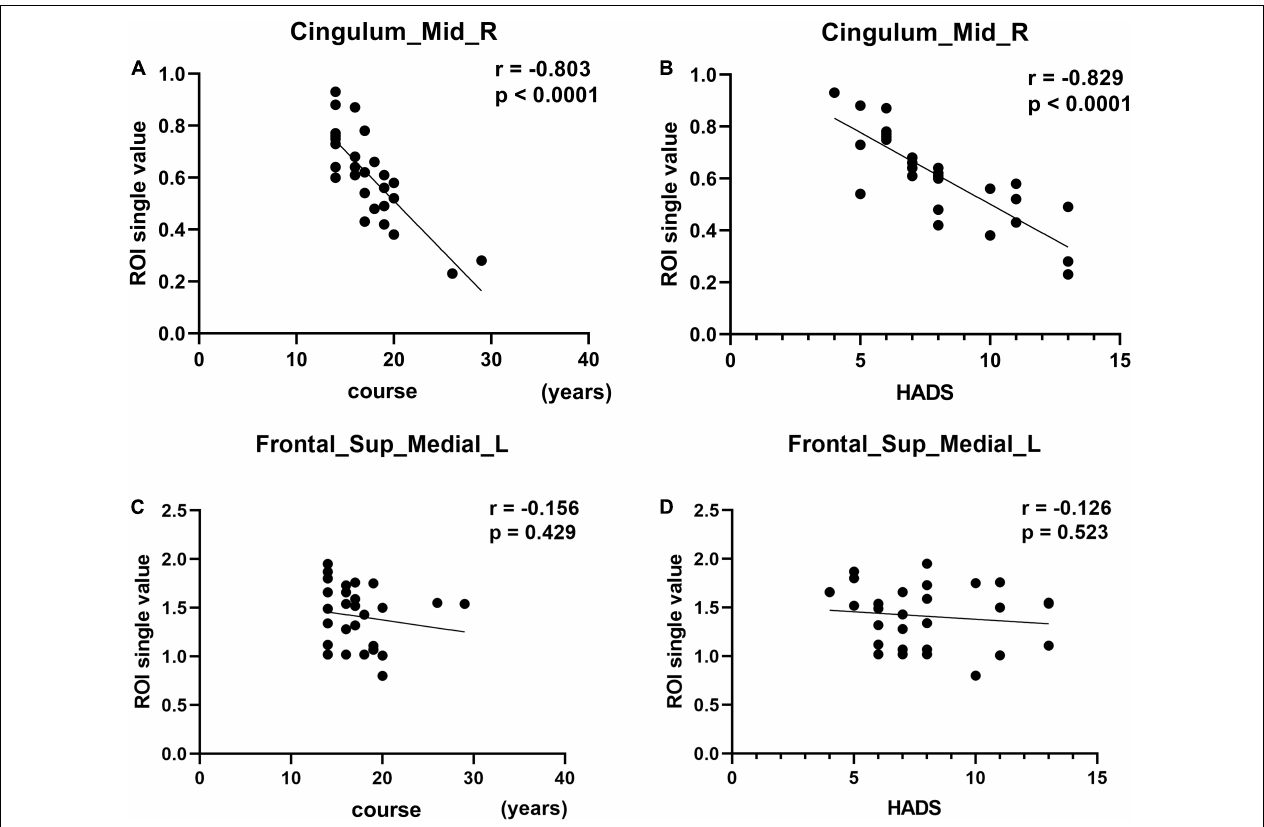
FIGURE 4 | Correlation between the fALLF values of the two brain regions and course and HADS. In the CS group, the fALFF value of the Cingulum_Mid_R showed a negative correlation with the course ( A , r = –0.803, p < 0.0001). The fALFF value of the Cingulum_Mid_R showed a negative correlation with the HADS ( B , r = –0.829, p < 0.0001). The fALFF values of Frontal_Sup_Medial_L showed no correlation with the course of the disease ( C , r = –0.156, p = 0.429) or HADS score ( D , r = –0.126, p = 0.523).